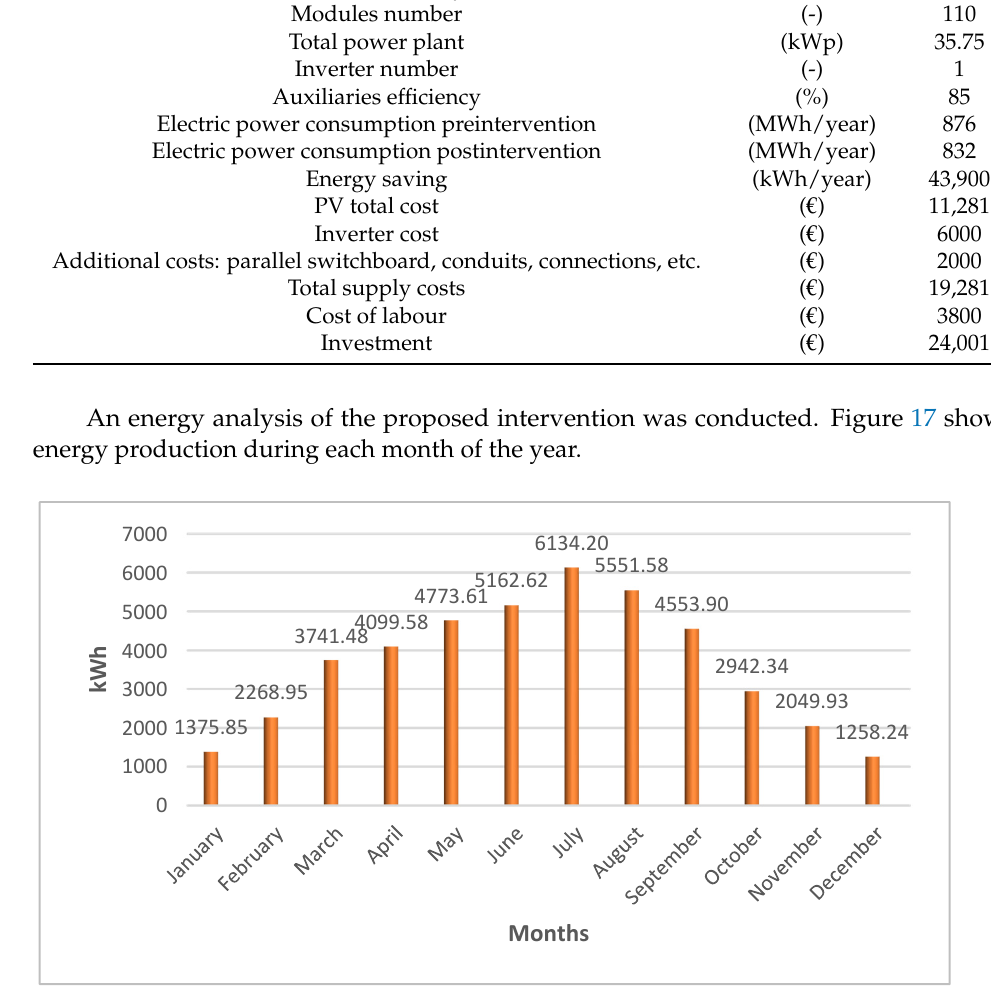
Figure 17. Monthly photovoltaic production.